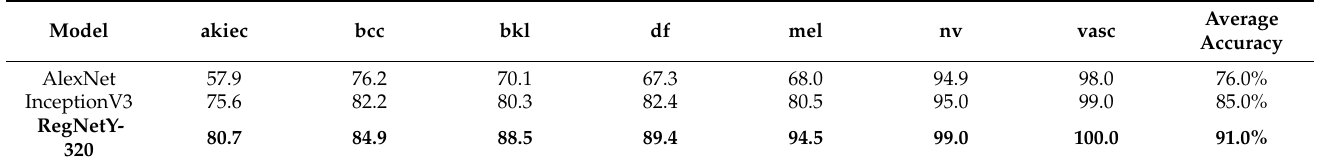
Table 4. The accuracy of the models for each